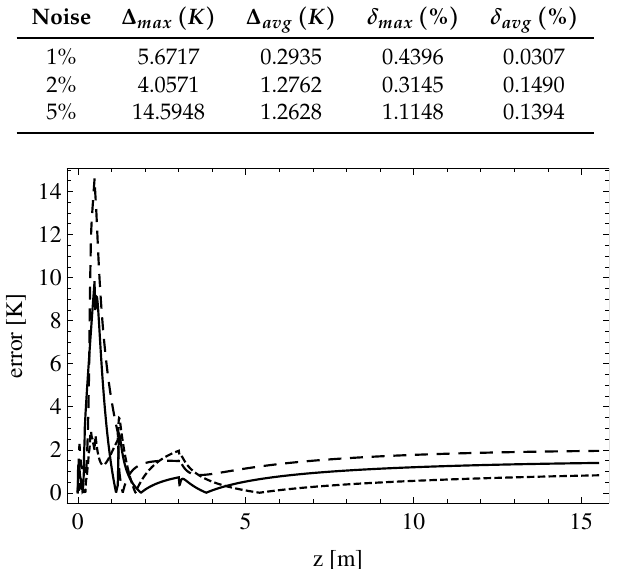
Figure 9. Absolute error of temperature reconstruction in the control points for measurements read at every 0.01m and burdened by a 5% error (two steps